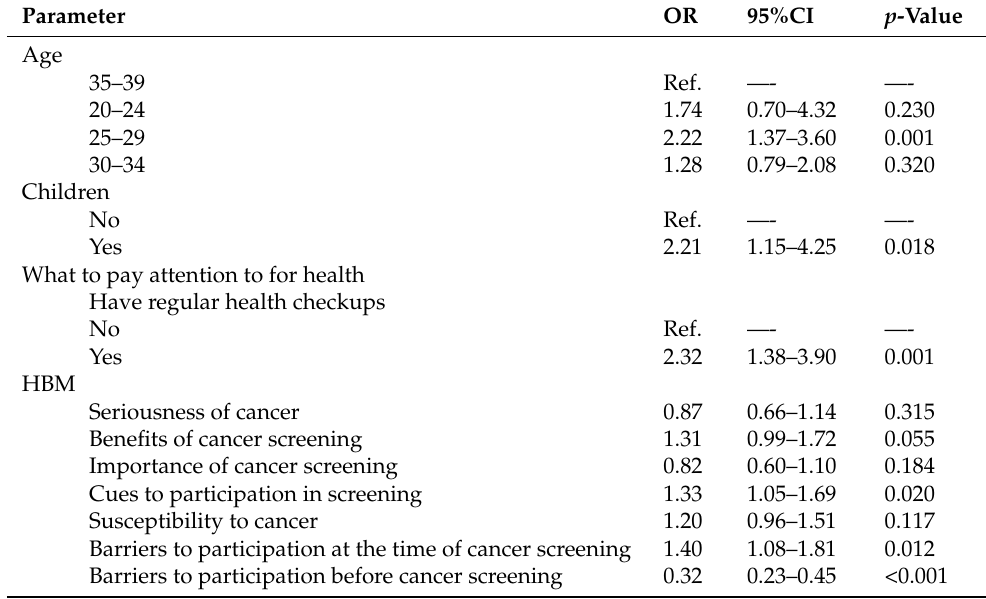
Table 4. Psychological and personal characteristics affecting participation of